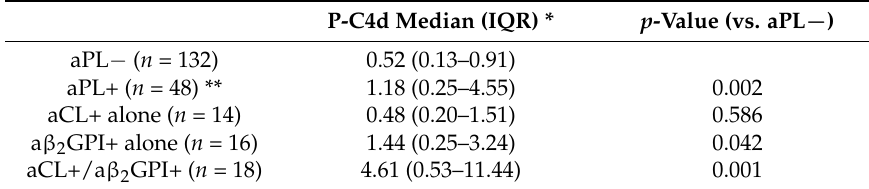
Table 4. Comparison of P-C4d levels in SLE patients with or without aPL